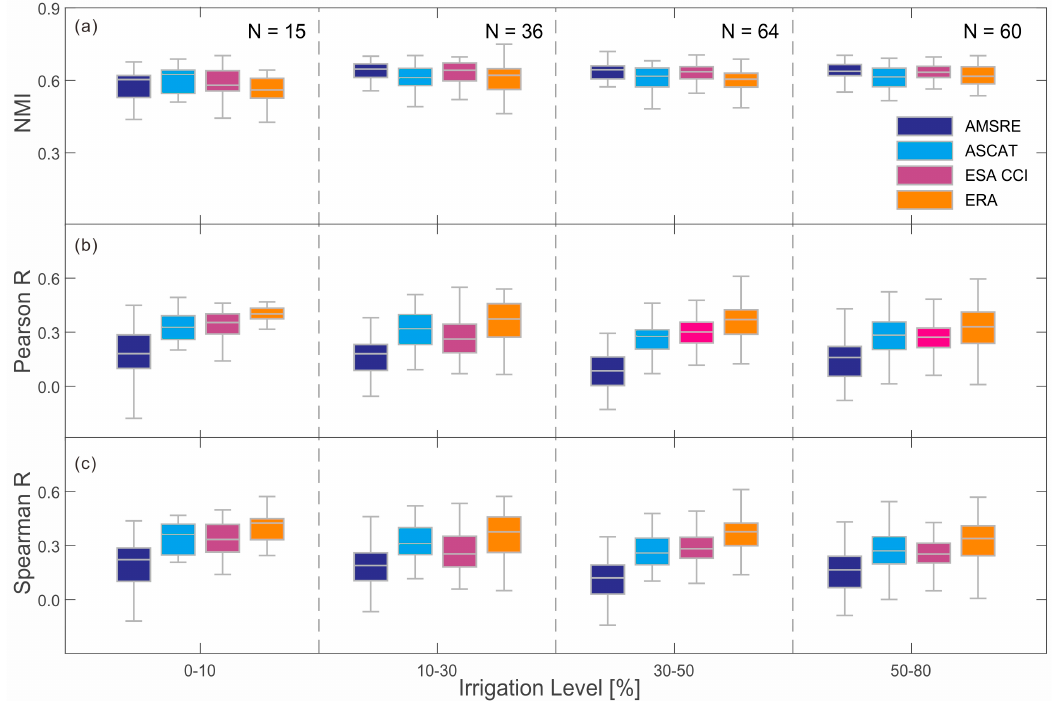
Figure 4. Validation of the remote sensing data sets against observations from agro-meteorological sites that located in grids with four different AEI levels of 0–10%, 10–30%, 30–50% and 50–80%, using metrics of ( a ) normalized mutual information, ( b ) Pearson correlation, ( c ) Spearman correlation. Numbers of agro-meteorological sites used for each irrigation levels are shown in the first row.